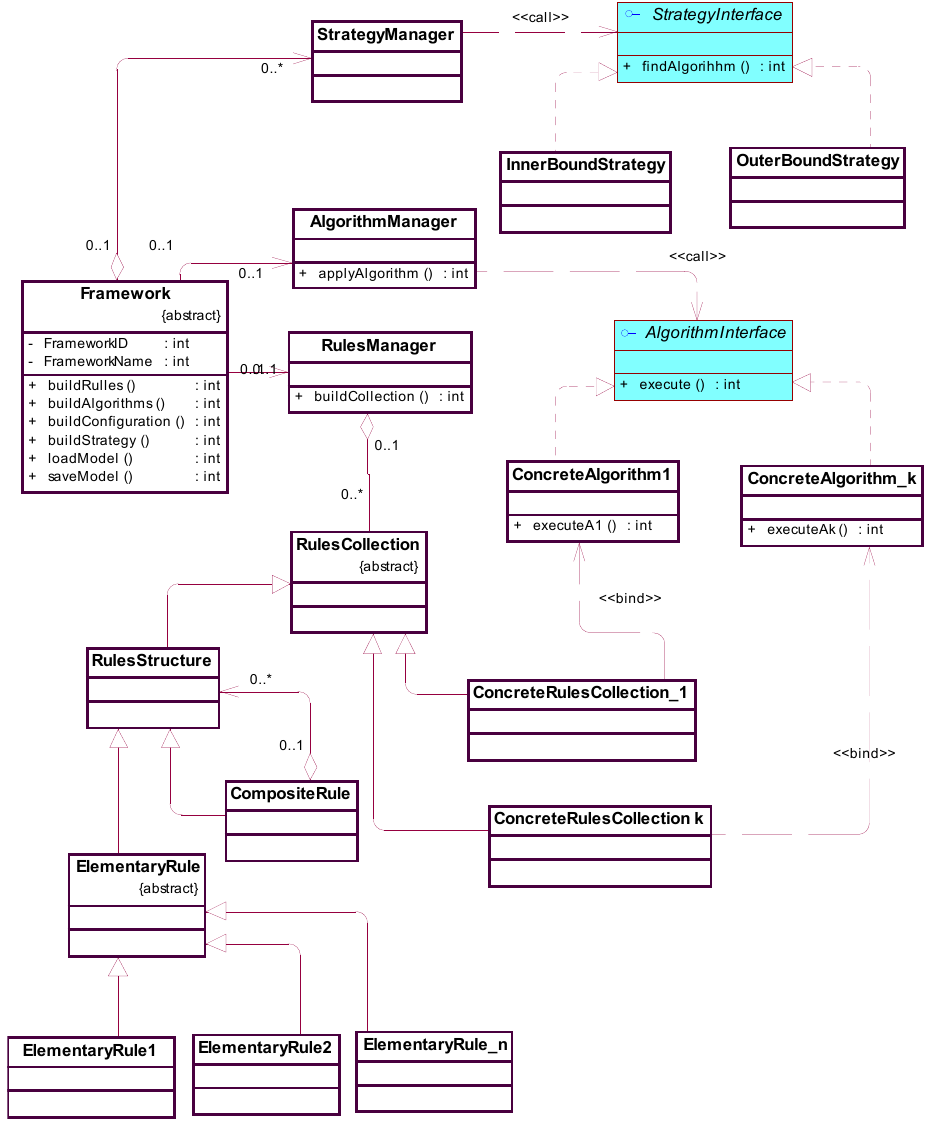
Figure 2. The initial framework conceptual model.